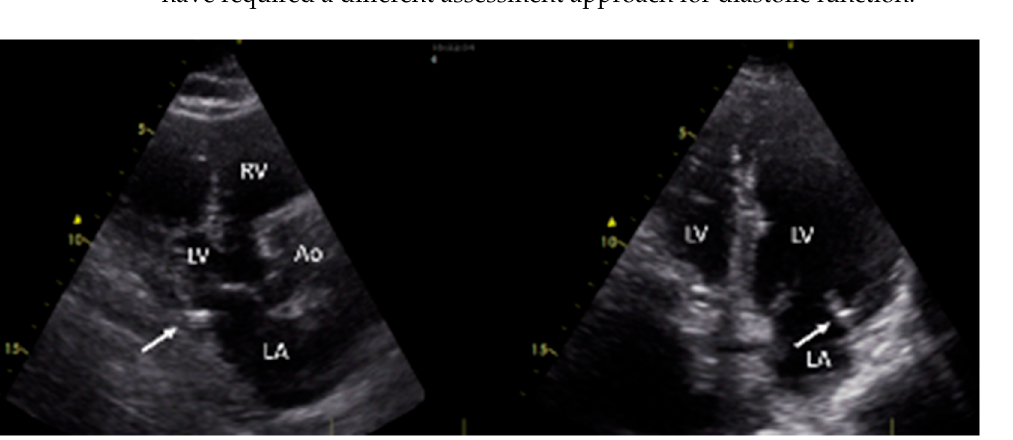
Figure 1. Transthoracic echocardiography in long parasternal view and modified apical four-chamber view showing mitral annular calcification in an enrolled patient. Ao — aorta; LA — left atrium; LV — left ventricle; RV — right ventricle.